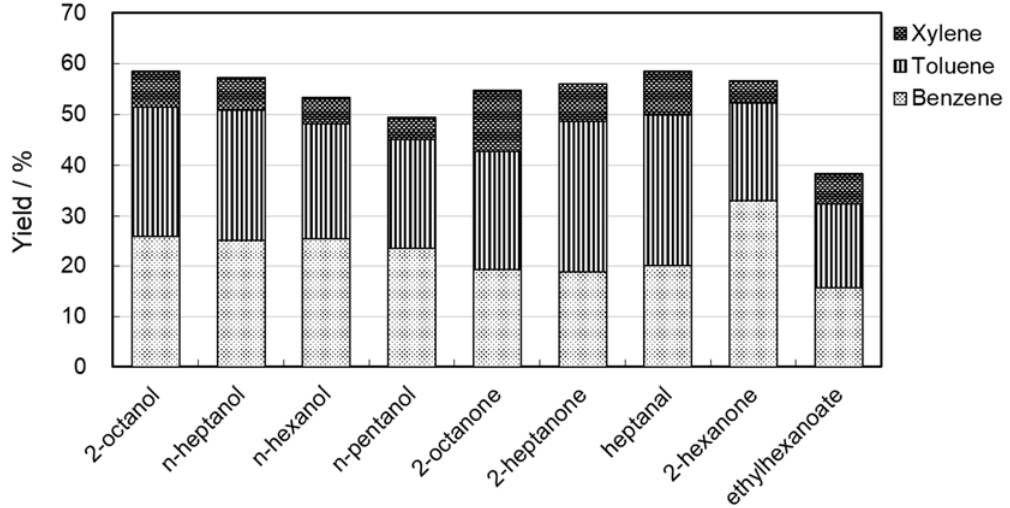
Figure 5. Comparison of yields of benzene, toluene, and xylene produced from various oxygenated reactants on Zn-MFI at 773 K. Reaction conditions: catalyst 1.0 g; total gas